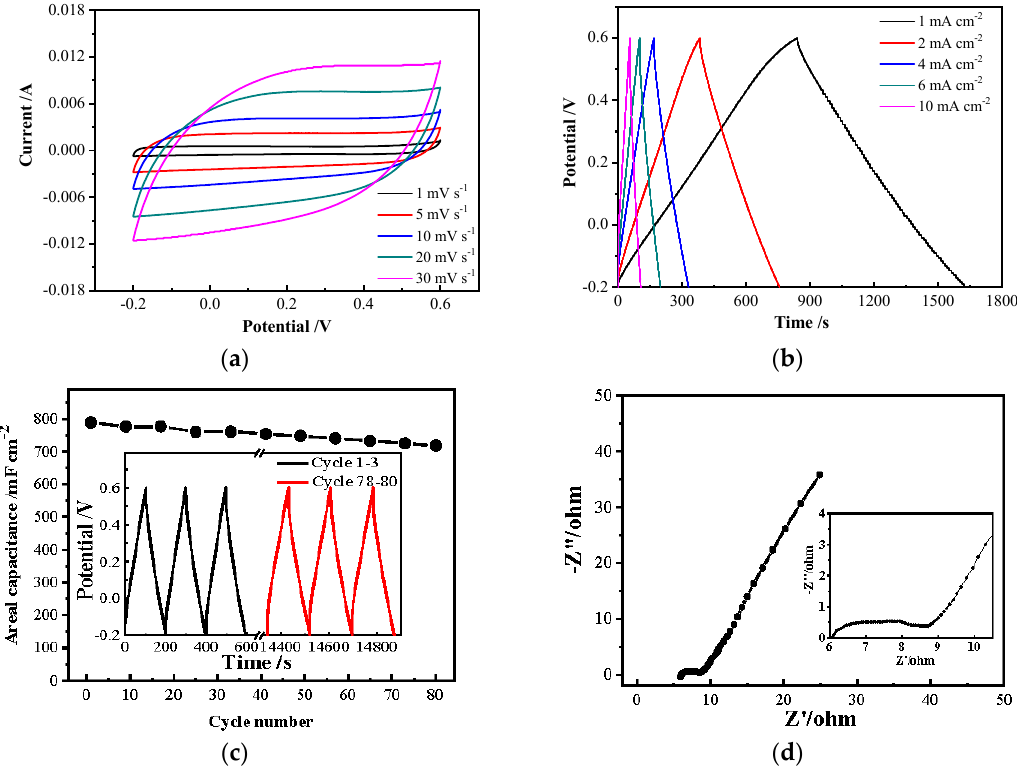
Figure 7. Electrochemical performances of PPy/BC nanocomposite prepared based on response surface: ( a ) cyclic voltammetry curves at different scan rates; ( b ) galvanostatic charge-discharge curves at different current densities; ( c ) cycle stability; ( d ) electrochemical impedance spectroscopy curves.